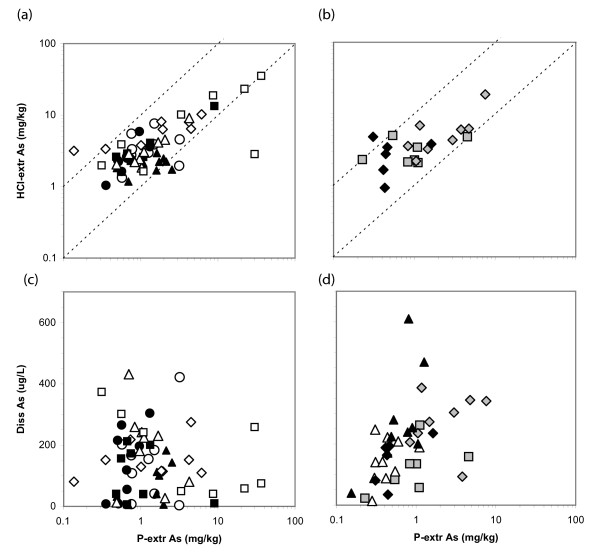
Comparison of P-extractable As concentrations with the acid-leachable As content of the sediment collected with from (a) Chakdaha, India, and (b) Balia, Para, Bangladesh. The two dashed lines in each panel correspond to a one-to-one correspondence and 10-fold higher HCl-extractable As concentrations, respectively. Also shown are dissolved As concentrations as a function of P-extractable As (c-d). Symbols identifying the profiles are the same as in Figure 2.